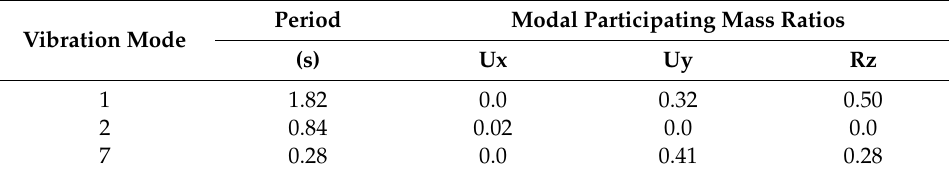
Table 4. Modal parameters of the left lateral block of building